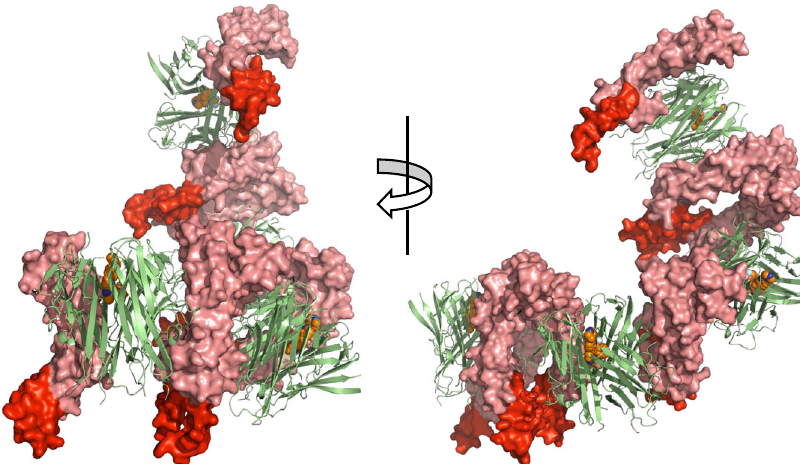
Fig. 3 Extended TNF – TNFR1 chain. Four copies of trimeric mTNF (green ribbons) linked by hTNFR1 dimers (pink surface rendered) as present in the crystal lattice (PDB: 7KP8 [https://www.rcsb.org/structure/unreleased/7KP8]). Membrane proximal ends of each receptor are highlighted in